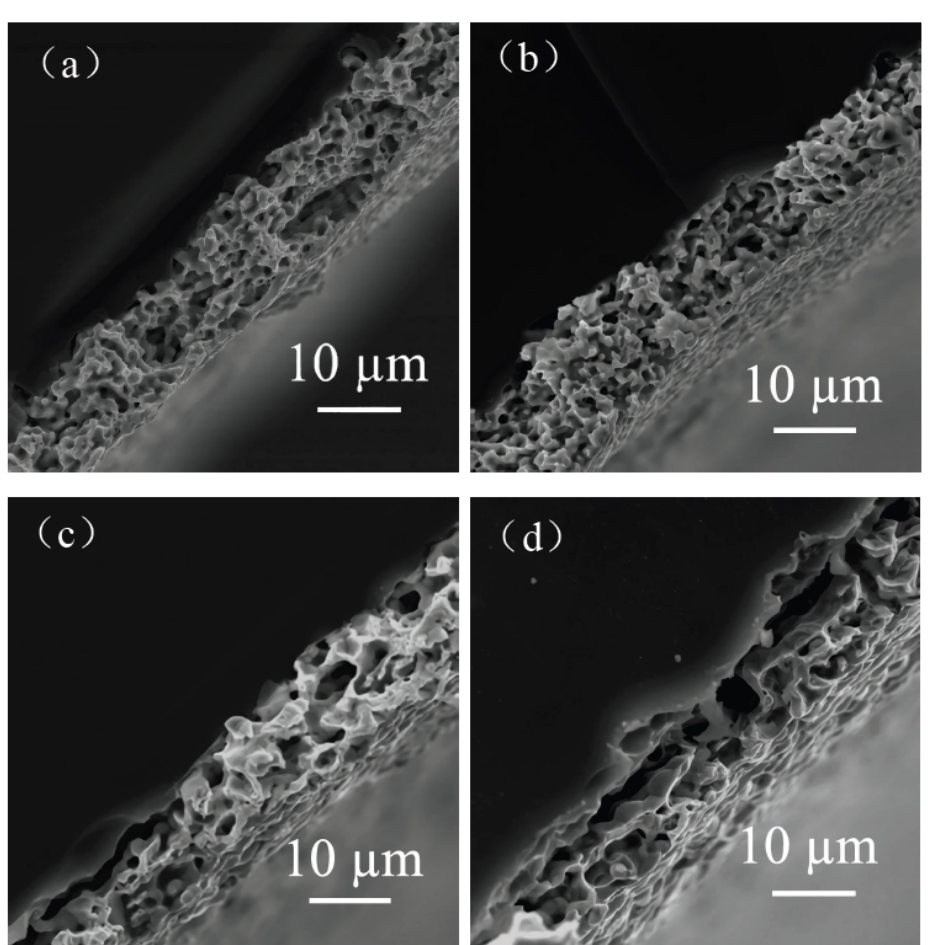
Figure 9. Cross − sectional view of contact between the silver film of the flake silver powder with different contents and silicon substrate. Image ( a ) is a cross − section of the contact between the silicon substrate and silver film with 0 wt% flake silver powder. Image ( b ) is a cross − section of the contact between the silicon substrate and silver film with 30 wt% flake silver powder. Image ( c ) is a cross − section of the contact between the silicon substrate and silver film with 50 wt% flake silver powder. Image ( d ) is a cross − section of the contact between the silicon substrate and silver film with 100 wt% flake silver